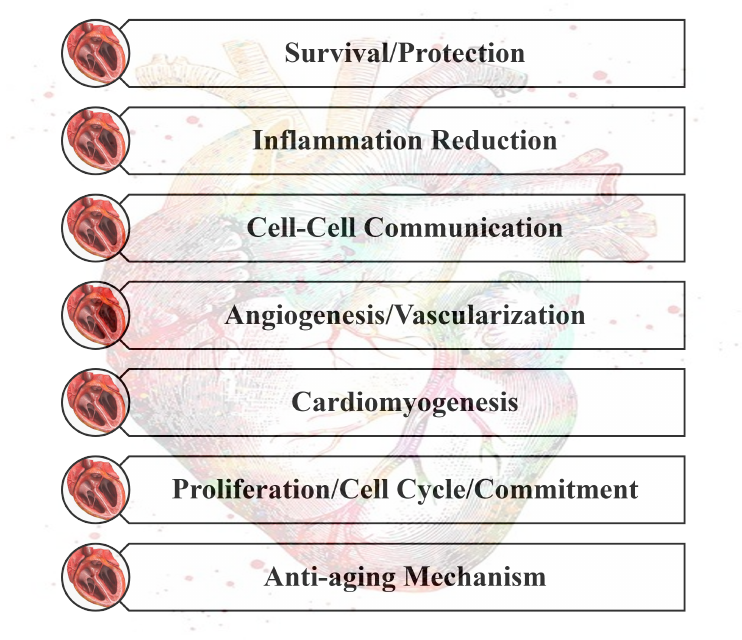
Figure 2. Mechanisms of cardiac repair and